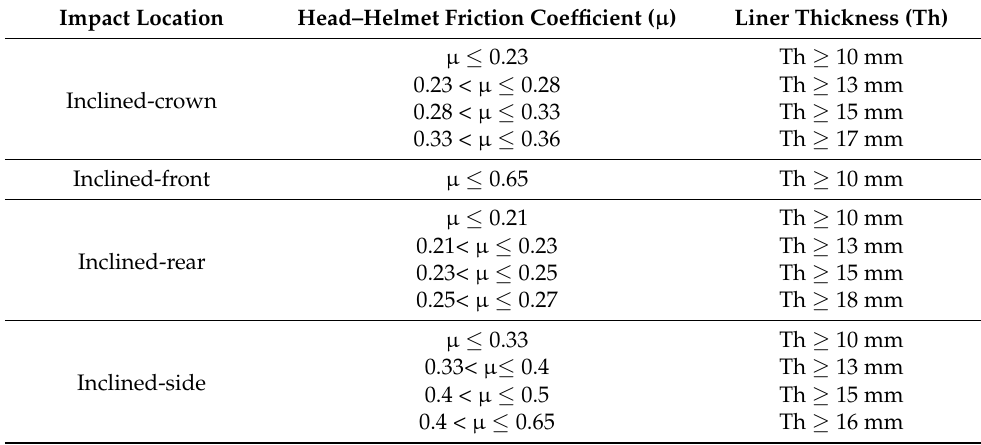
Figure 15. Relationship between helmet parameters and the rotational acceleration predicted by the ROM with the inclined anvil drop test at ( a ) crown, ( b ) front, ( c ) rear, and ( d ) side impact locations. Table 5. Suggested ranges of a suitable friction coefficient and liner thickness. Table 5. Suggested ranges of a suitable friction coefficient and liner